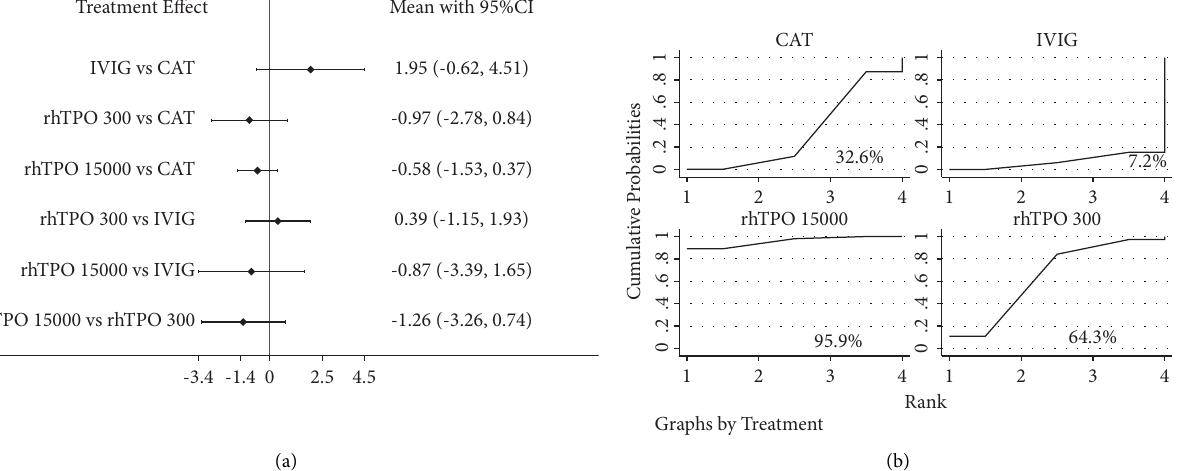
Figure 5: Network meta-analysis of the relative efcacy (a) and the rank probabilities (b) among diferent treatment strategies in terms of the length of ICU stay. NAT, no additional treatment; IVIG, intravenous immunoglobulin; rhTPO 300, 300U/kg/d recombinant human thrombopoietin; rhTPO 15000, 15000U/d recombinant human